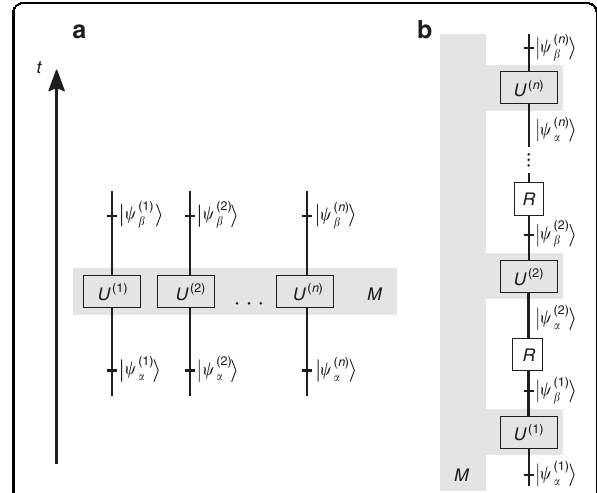
Fig. 2 Robust weak measurement: theoretical framework. a A measuring device M is coupled simultaneously to n particles of a pre- and postselected system. b The measuring device is coupled to the same particle at n times with particular pre- and postselection at each time. After each postselection onto j ψ ð k Þ β i , a unitary rotation R restores (cid:3) (cid:3) the preselection state ψ α